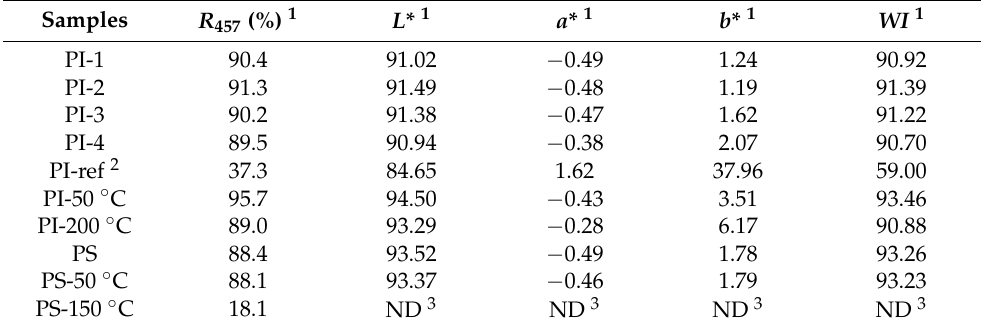
Table 3. Comparison of optical properties of PI-3 and PS NFMs before and after thermal treatment. Samples